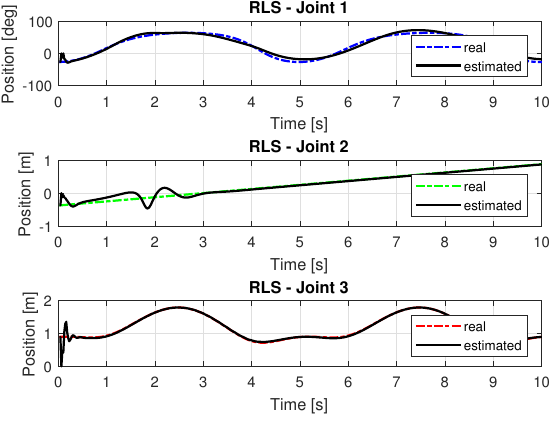
Figure 11. Trajectory in the joint space identified with RLS.